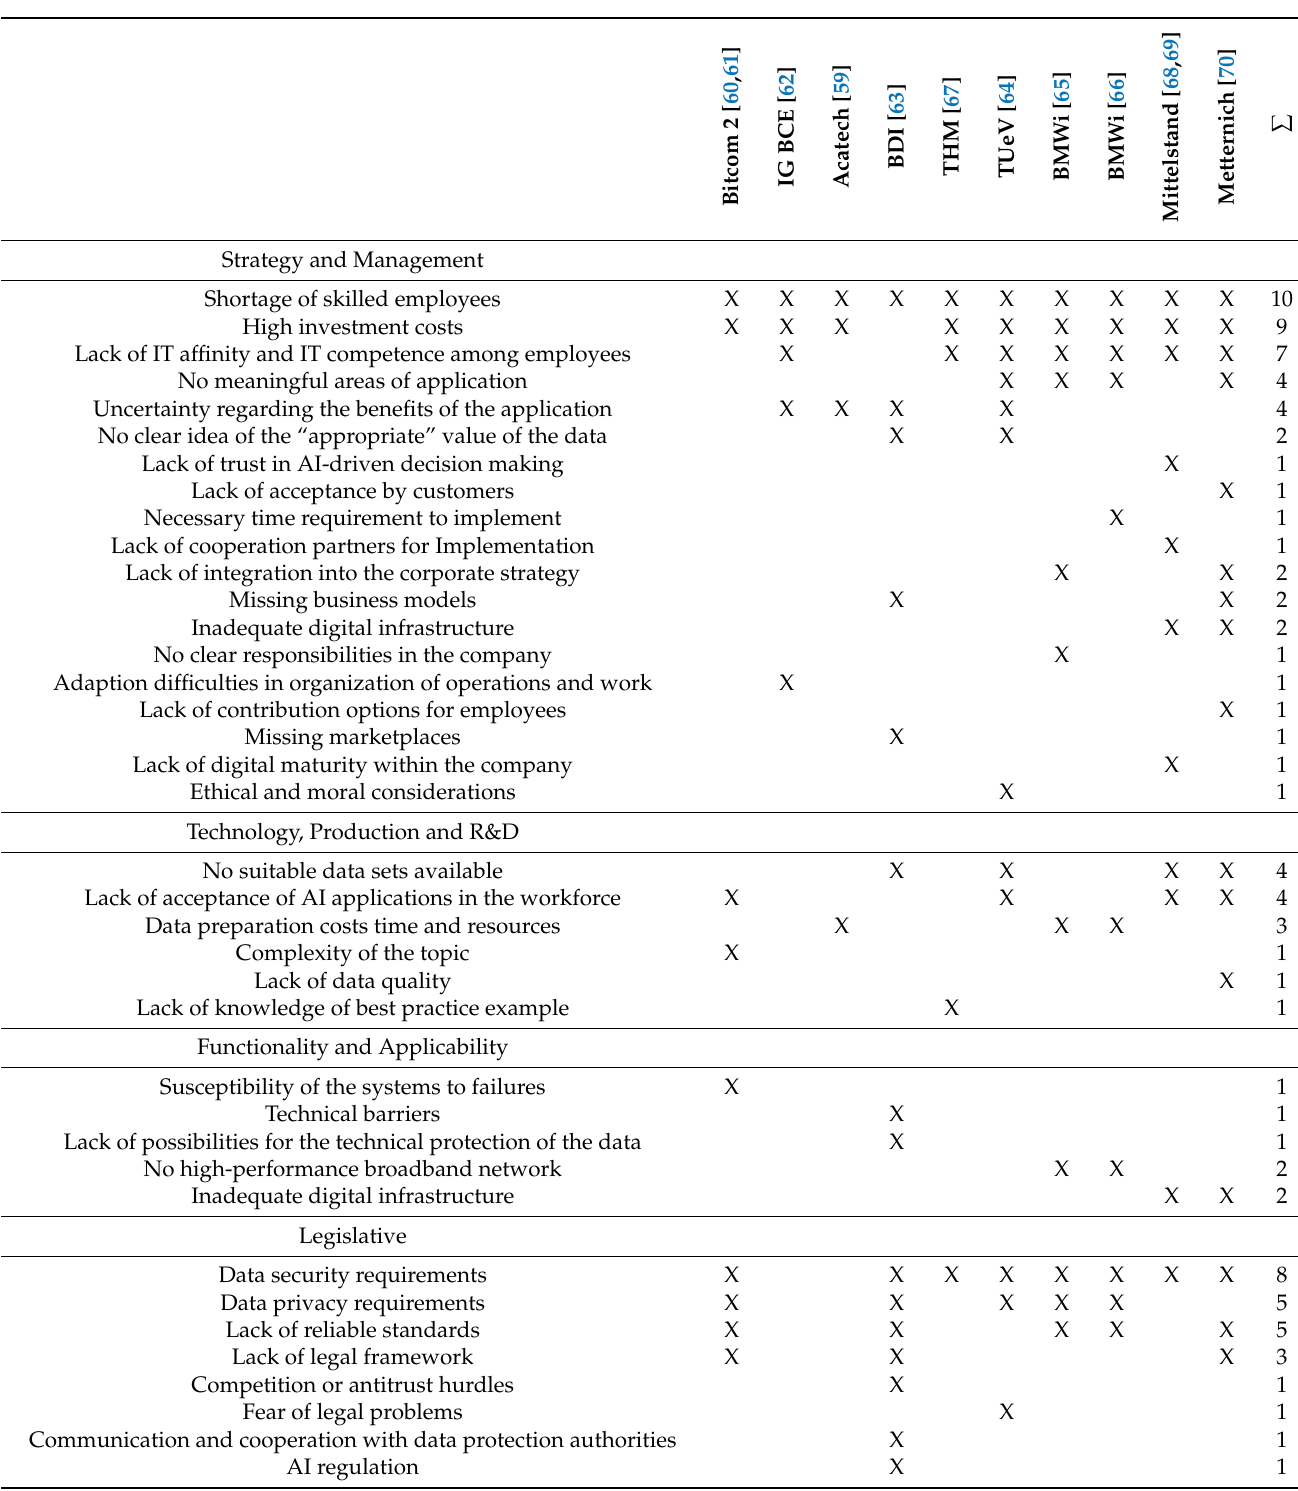
Table 5. Overview of surveys to barriers to the digitization and use of AI-technologies in industrial